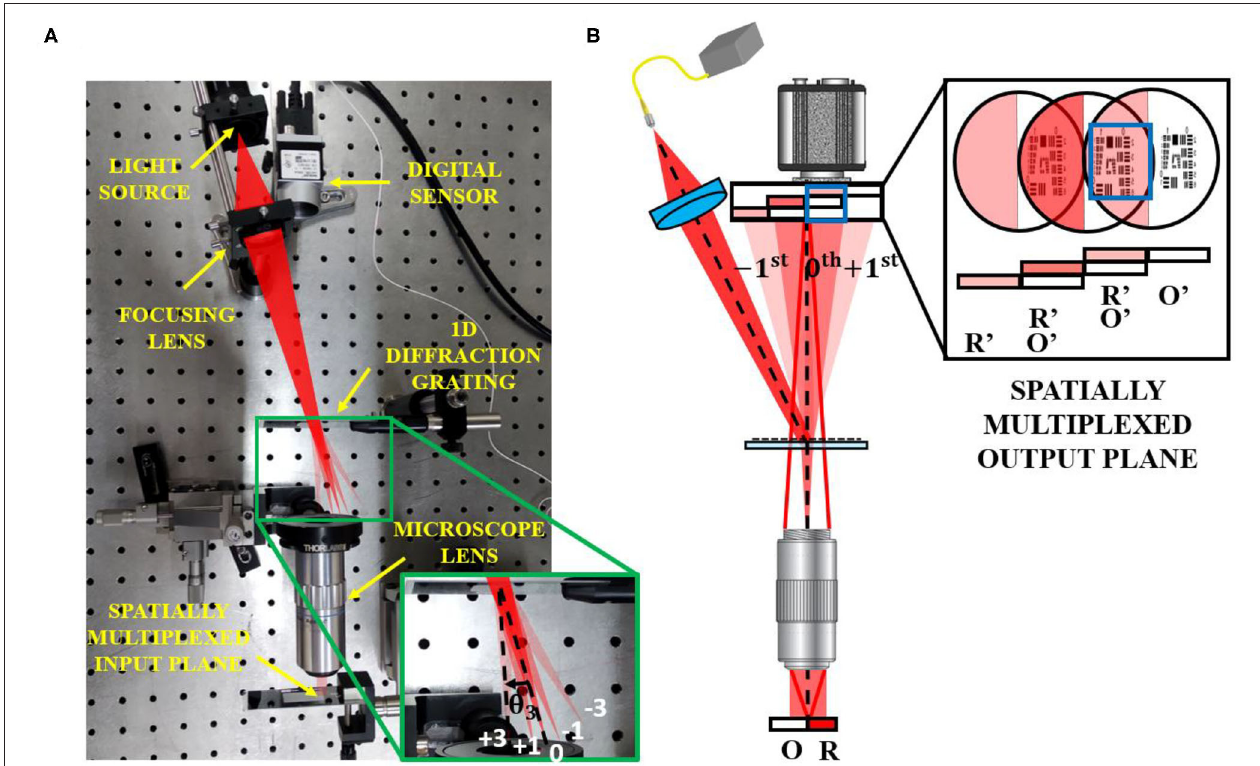
FIGURE 1 | SER-DHM layout. (A) Picture of the experimental setup where the illumination arm is highlighted, and the green rectangle magnifies the diffraction order’s direction for clarity. (B) Optical scheme and ray tracing of both illumination and interferometric arms, including a frame with the output plane (black rectangle) and the recording region (blue rectangle) where the digital sensor is